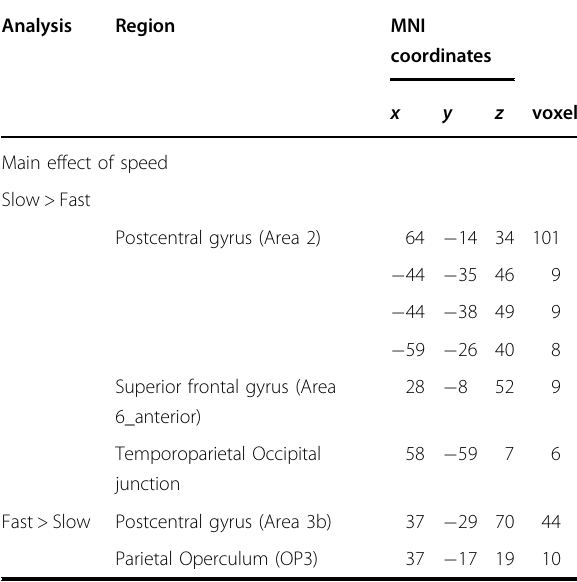
Table 2 Activations associated with the whole-brain, gray matter 2 × 2 ANOVA analysis, expressed by peak scores in MNI space coordinates ( x , y , z